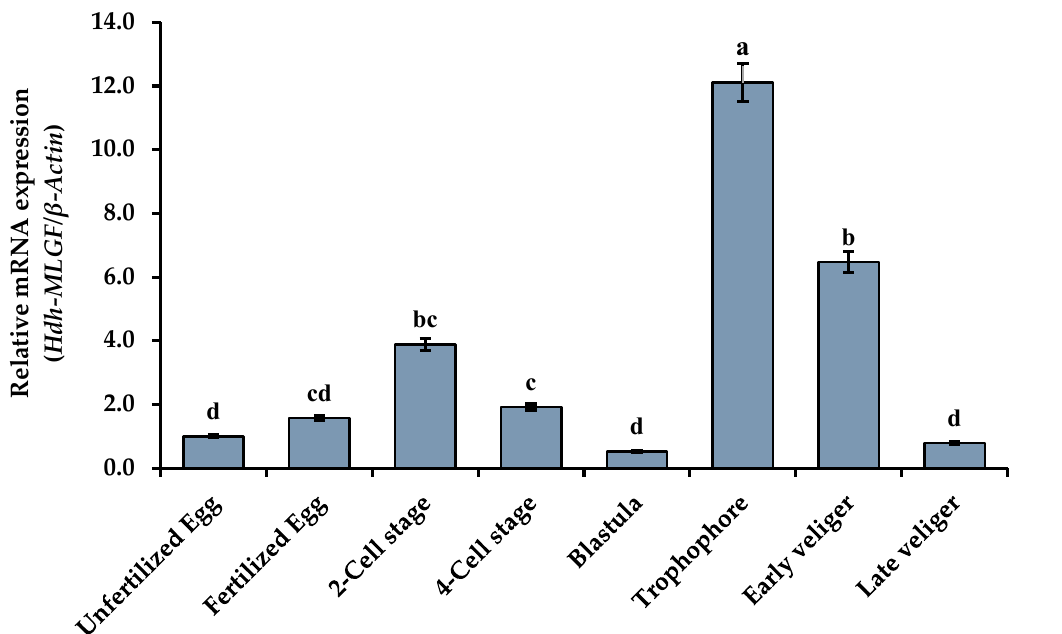
Figure 10. Expression of Hdh-MLGF at different stages of embryonic and larval developmental stages of Pacific abalone, H. discus hannai. In bar graph, error bars indicate standard error and different letters above the bar indicate significance difference ( p < 0.05).